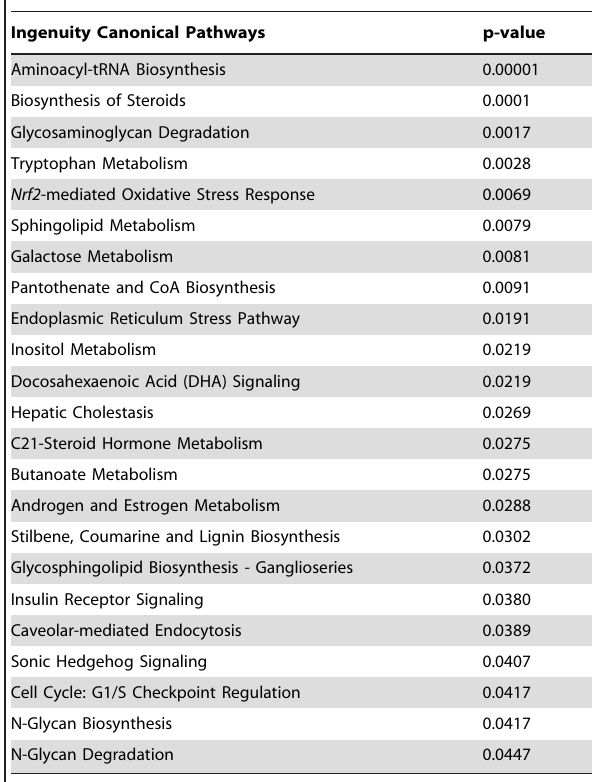
Table 1. Pathway analysis of gene expression in morphologically normal prostate tissue in men who have high dietary intake of tomato (n=49) compared with low dietary tomato intake (n=35).